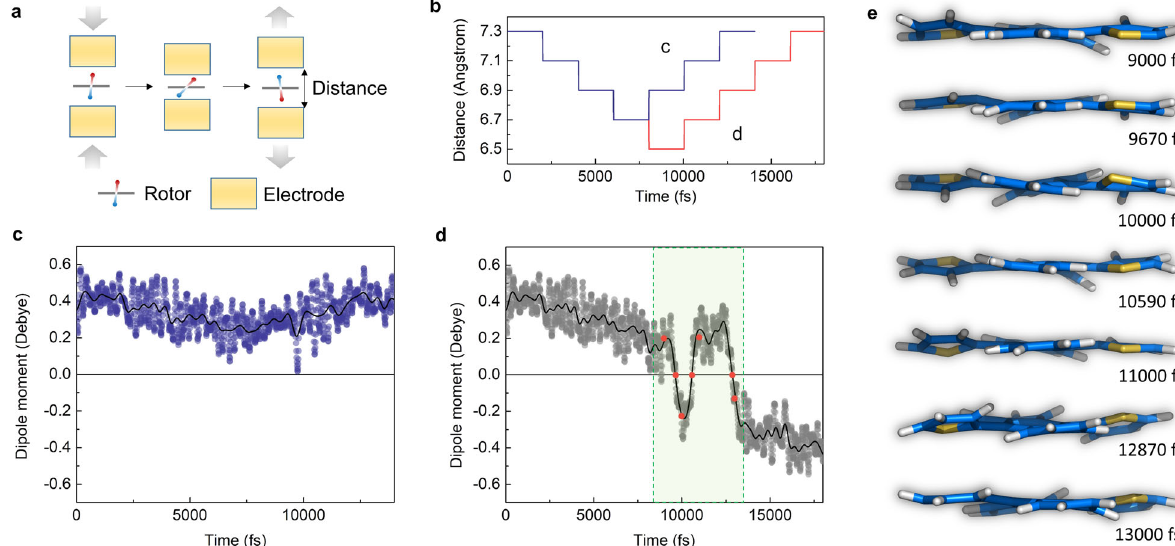
Fig. 5 Load-modulated rotor fl ip from density functional tight-binding molecular dynamics. a Illustration of mechanical loading process onto the molecular rotor. b The distance between the electrodes changes stepwise: for ( c ) it goes down from 7.3 Å to 6.7 Å and then back to 7.3 Å; for ( d ) it goes down further from 7.3 Å to 6.5 Å and then back to 7.3 Å. for trajectories. Dipole moment of rotor 2 diverges after 8 ps in ( c ) and ( d ). No dipole moment reverse is observed during the whole loading process in ( c ). In ( d ), the dipole moment reverses after several fl ips around zero in the region painted green. During the dynamic process, the snapshots of the rotor in red dots are shown in ( e ) with corresponding